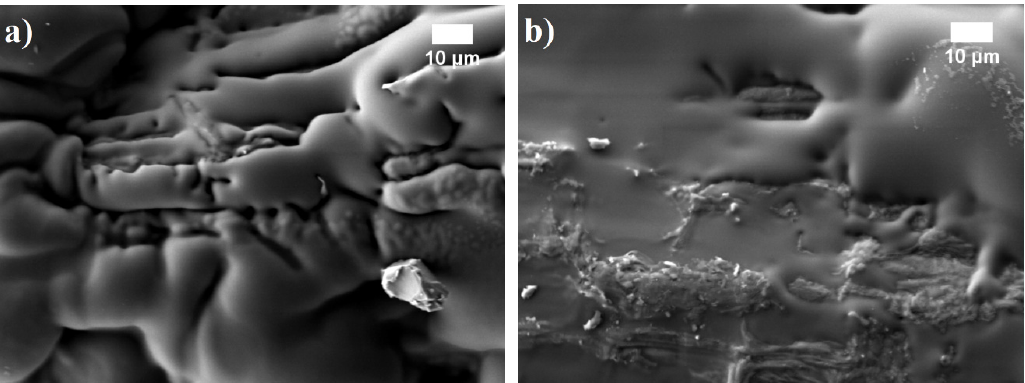
Figure 5. Solid tung tree oil on hemp shives aggregate at hardening temperature: ( a ) 90 °C and ( b ) 120 °C (magnification 1000×).